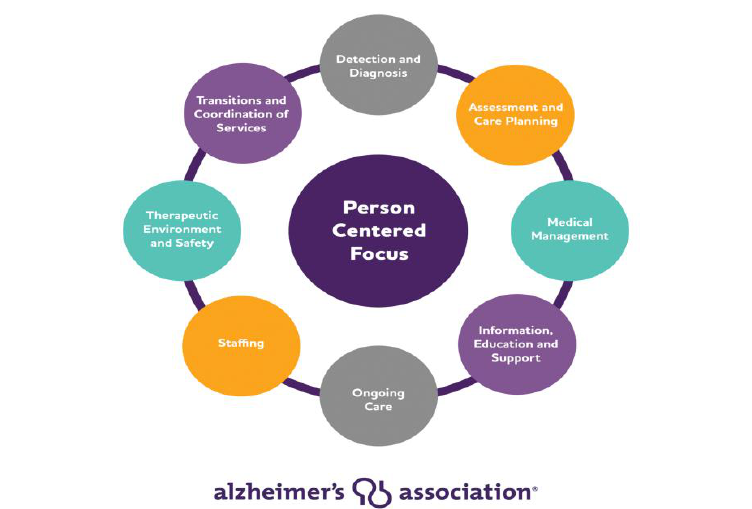
Figure 1. Dementia Care Practice Recommendations [1] (reproduced with permission).